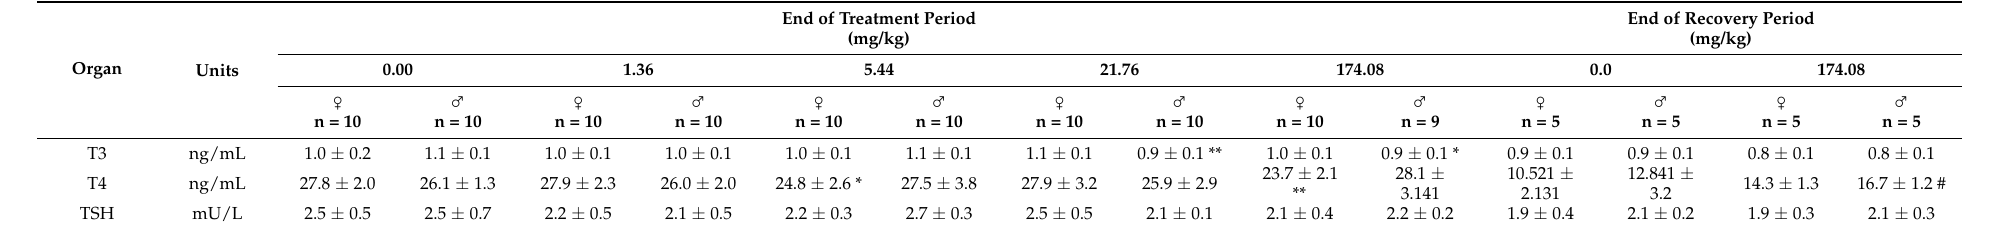
Table 3. Hormones in SD rats orally administered AQ for 90 days.